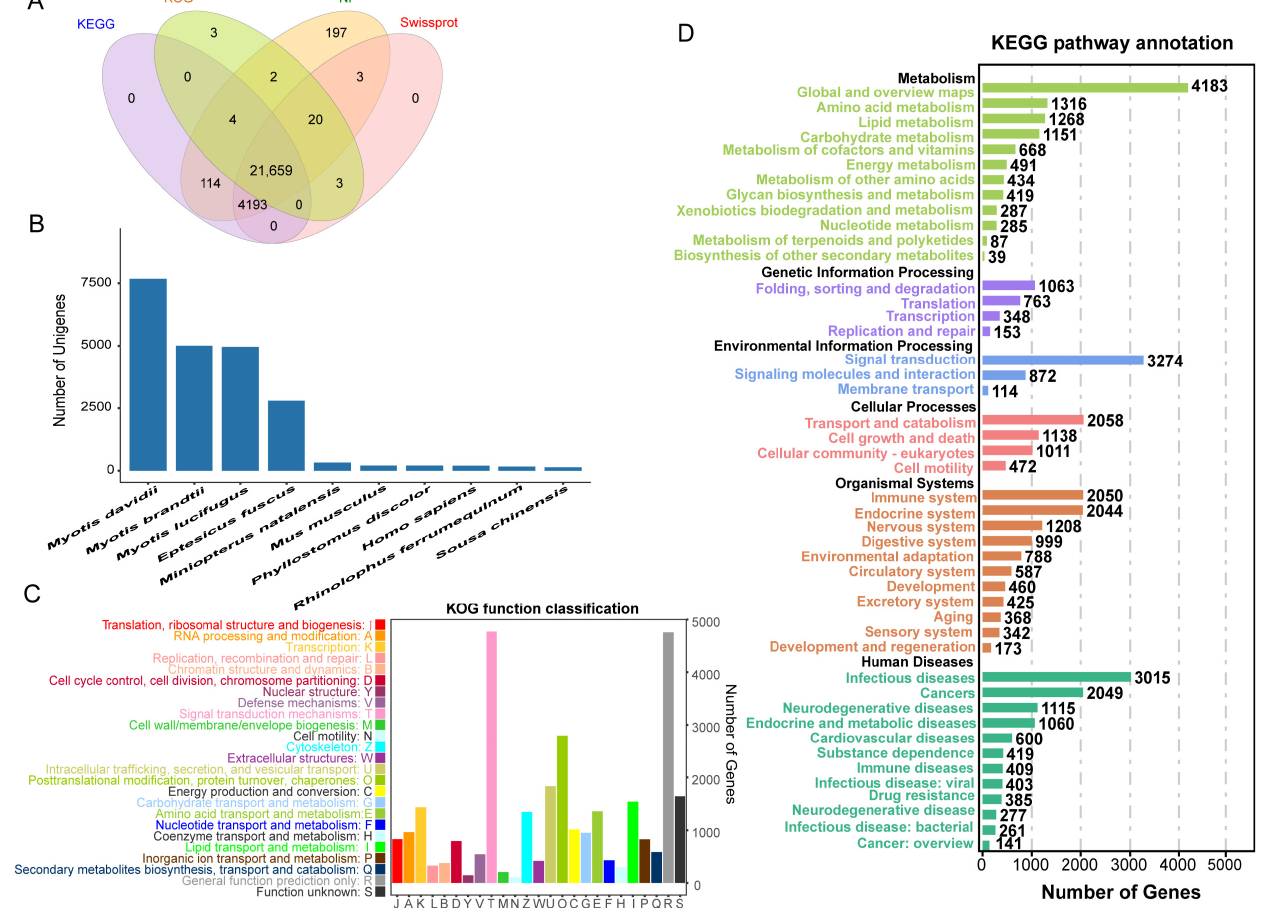
Figure 2. Functional annotation in M. pilosus . ( A ) Venn diagram of annotations in NR, KEGG, KOG, and Swiss-Prot databases. ( B ) Distribution of the top 10 species with matched transcripts in the NR database. ( C ) KOG categories of the transcripts. ( D ) KEGG pathways enriched by transcripts.